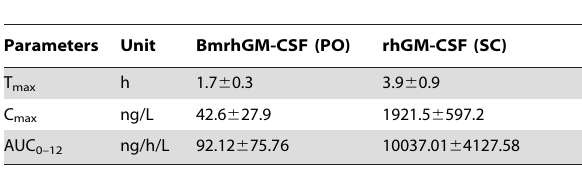
Table 1. Pharmacokinetic parameters of 19 subjects after the oral administration of 8 m g/kg BmrhGM-CSF or subcutaneous injection of 3.75 m g/kg